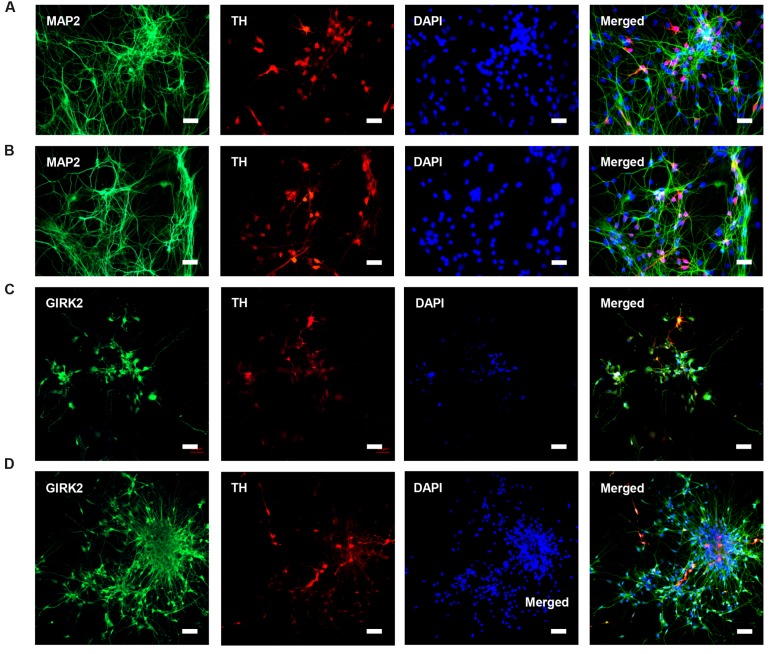
Characteristics of DA neurons from P96 and HN4 hESCs lines.
(A,B) P96 (A) and HN4 cell line (B) could be differentiated into DA, which co-expressed dopaminergic neuronal marker TH+/MAP2+. These cells were gathered in clusters, and neurites from different clusters formed some connections. (C,D) DA neurons from P96 (C) and HN4 cell line (D) co-expressed TH+/GIRK2+, which were A9 DA neurons. Scale bar = 50 μm.